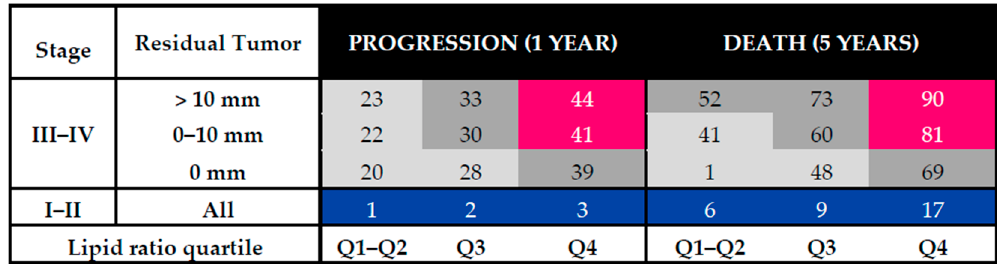
Figure 2. Risk (%) of progression in 1 year or death in 5 years, based on the lipid ratio quartile, stage, and success of tumor removal in surgery in the Turku cohort.